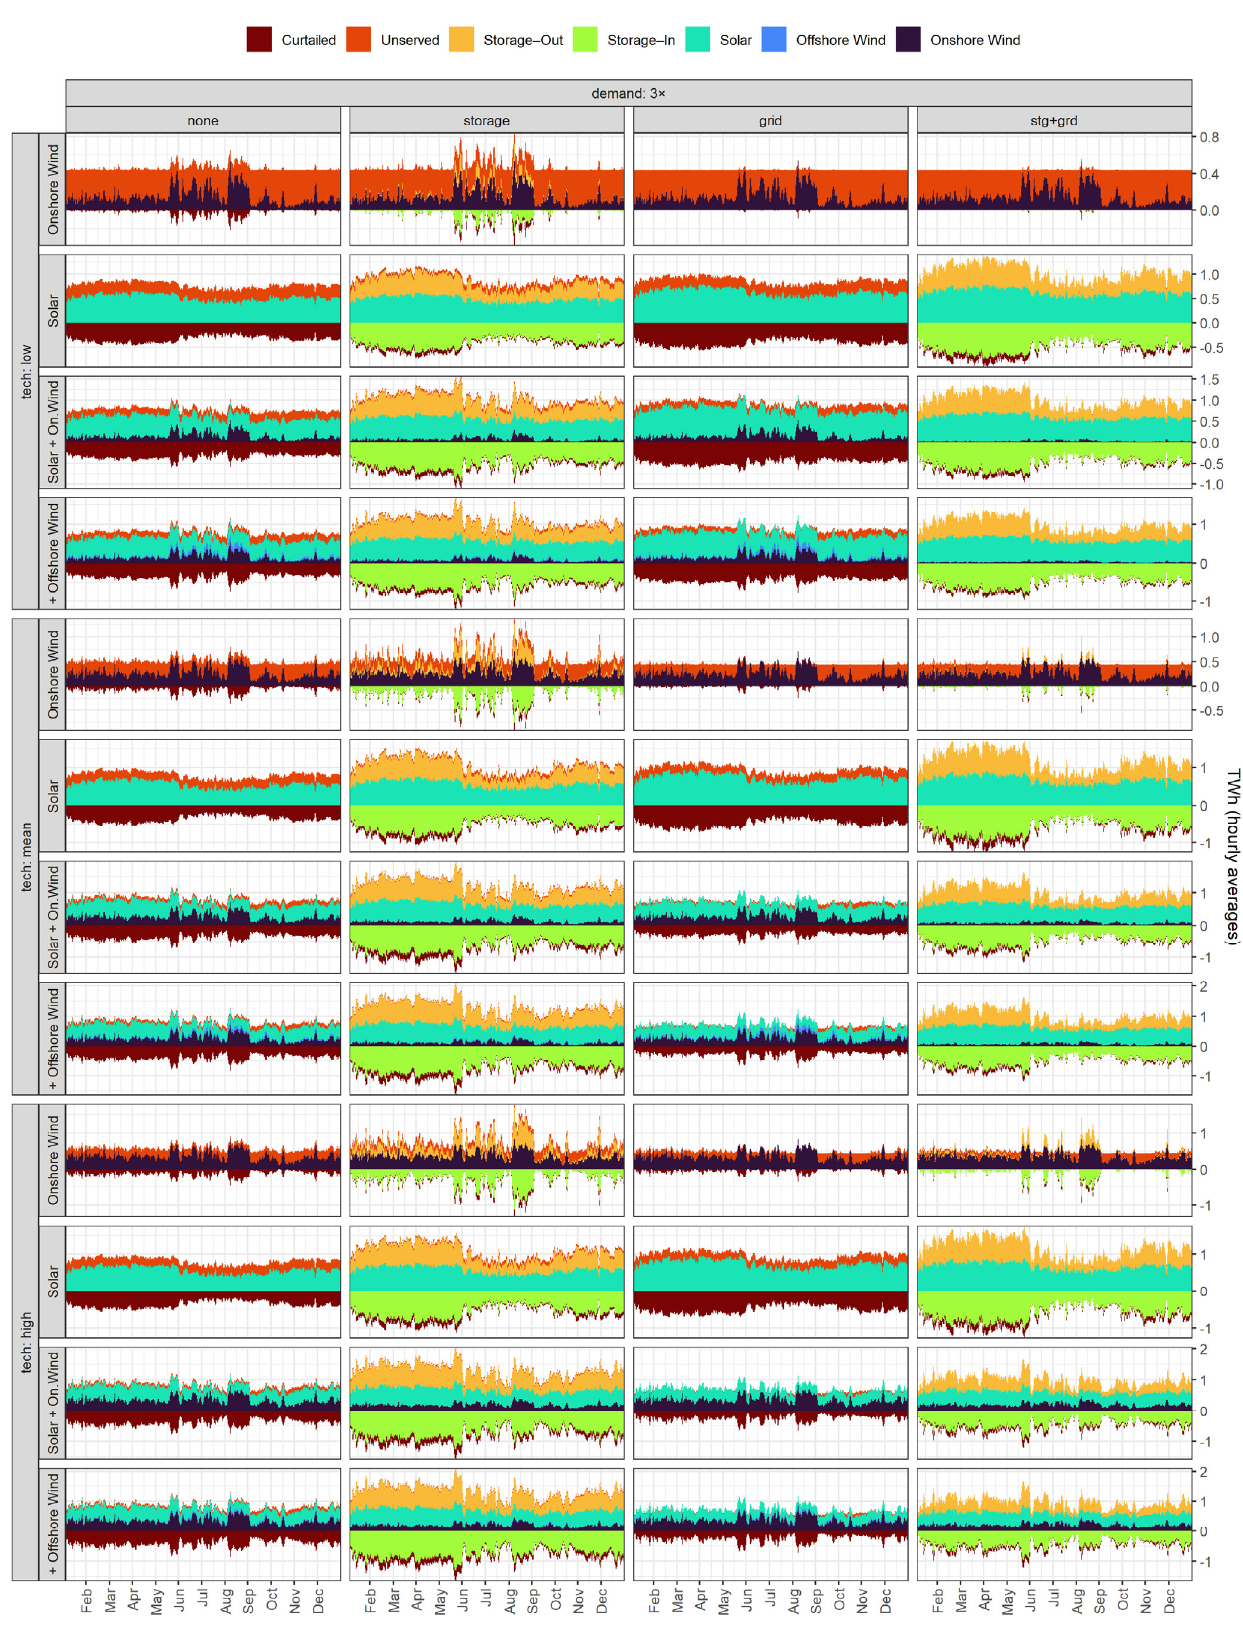
Figure A21. Annual operation profile by scenario (3× group), national aggregation, 2020 weather year.